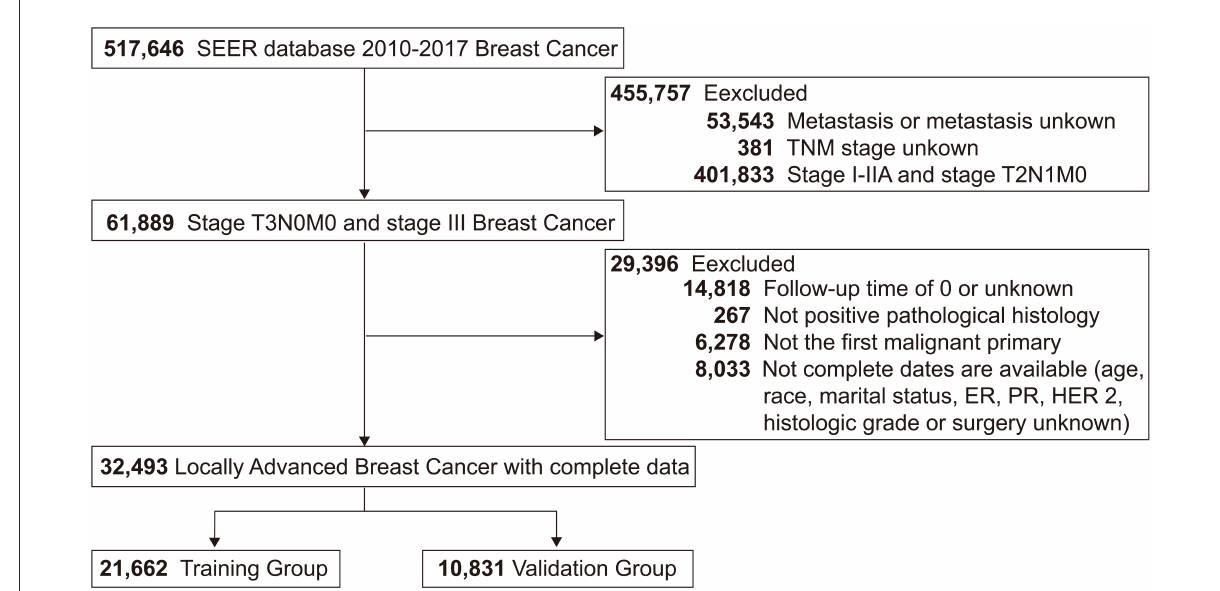
FIGURE1 Study flowchart of patients with locally advanced breast cancer (LABC) from the Surveillance, Epidemiology, and End Results (SEER) database. Bold values indicate the number of patients.